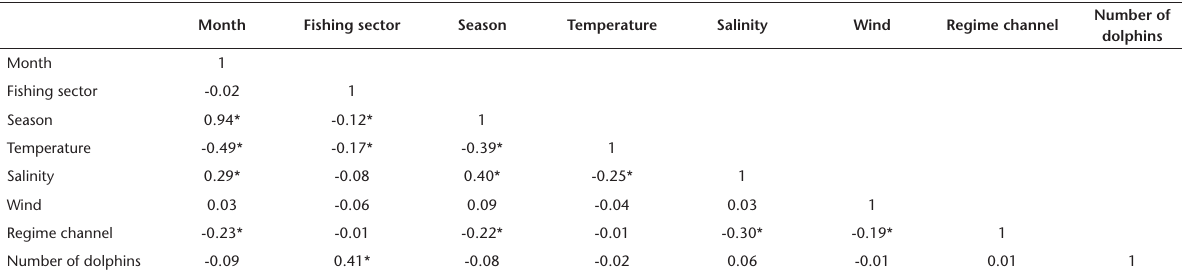
Table 1. Spearman (roh) correlations among